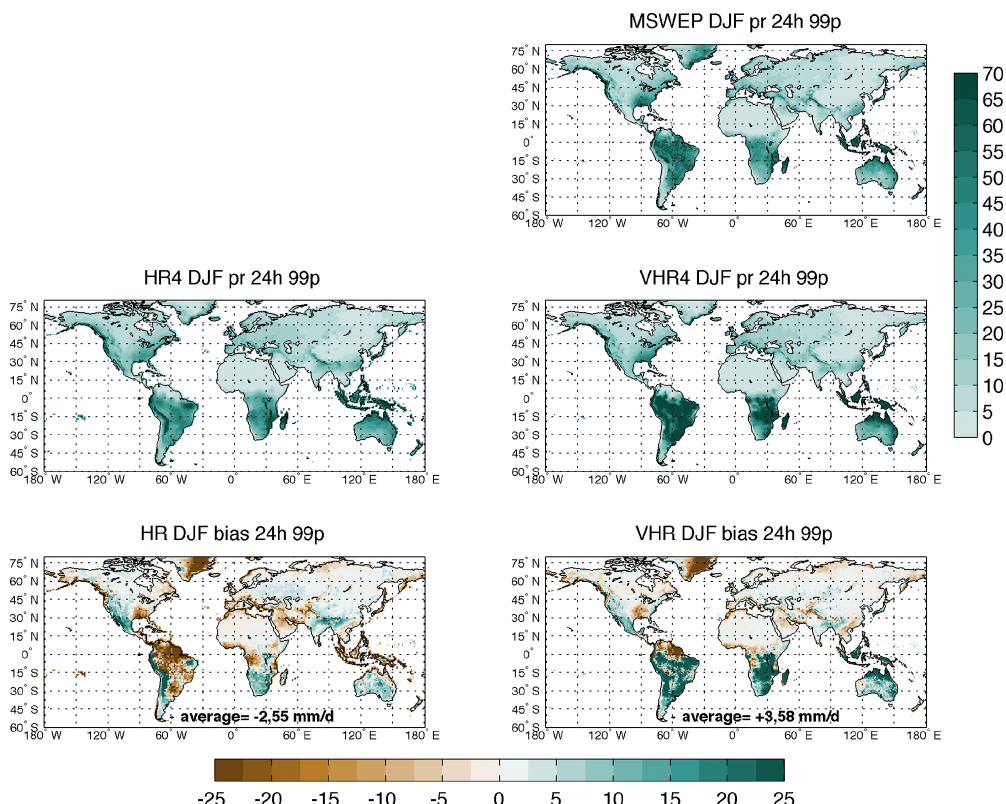
Figure 5. Winter (DJF) extreme precipitation (99th percentile, 99p) computed at the daily frequency. Upper panel shows MSWEP observa- tional results. Central panels show model results (HR on the left and VHR on the right) and lower panels show the relative model bias. Units are [mmd − 1 ]. Vertical color bar refers to the three upper panels, while the horizontal color bar refers to the two bottom